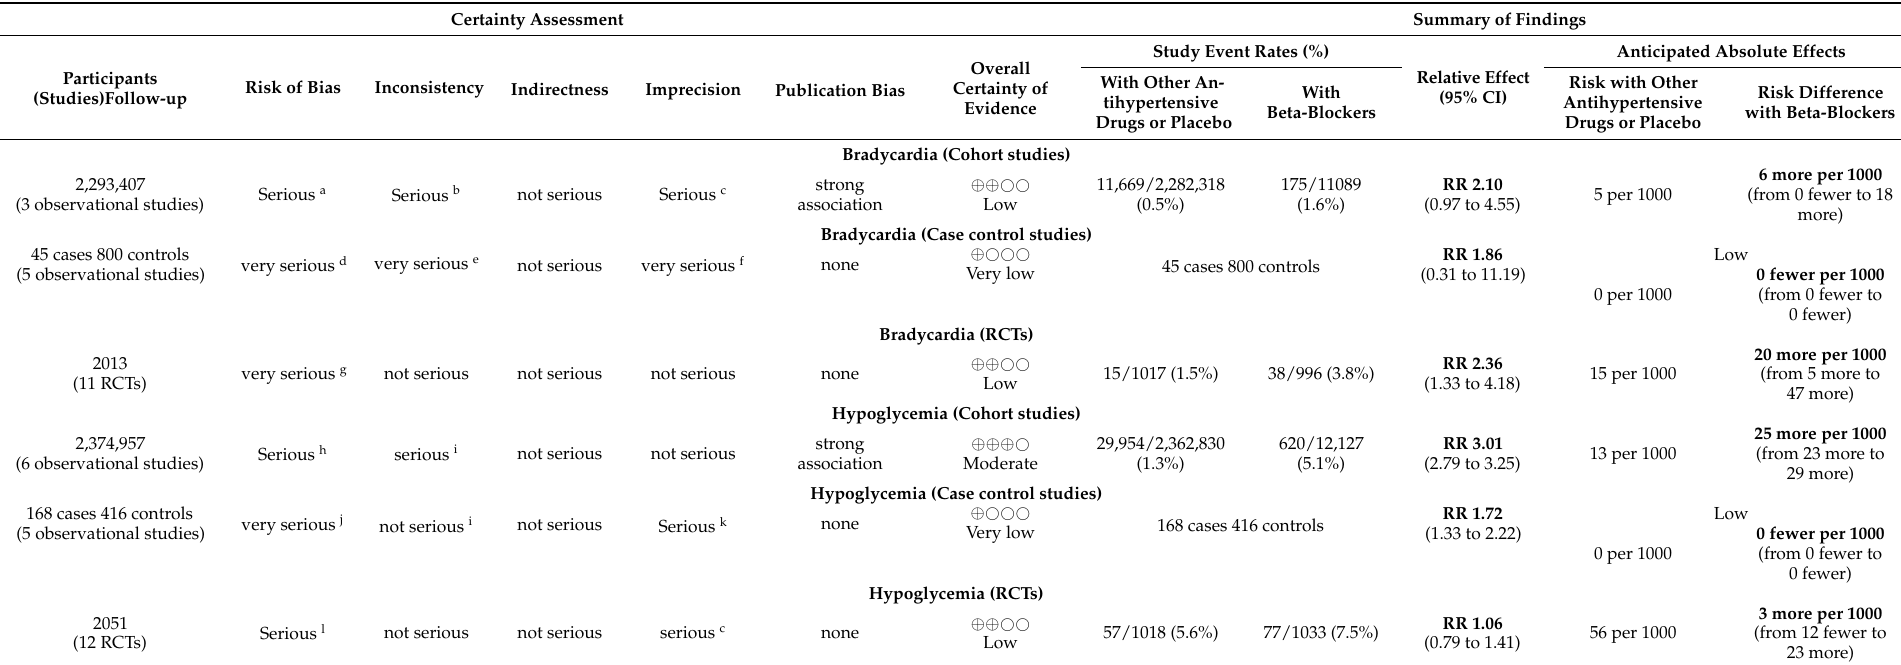
Table 9. Beta-blockers compared to other antihypertensive drugs or placebo in mothers with gestational